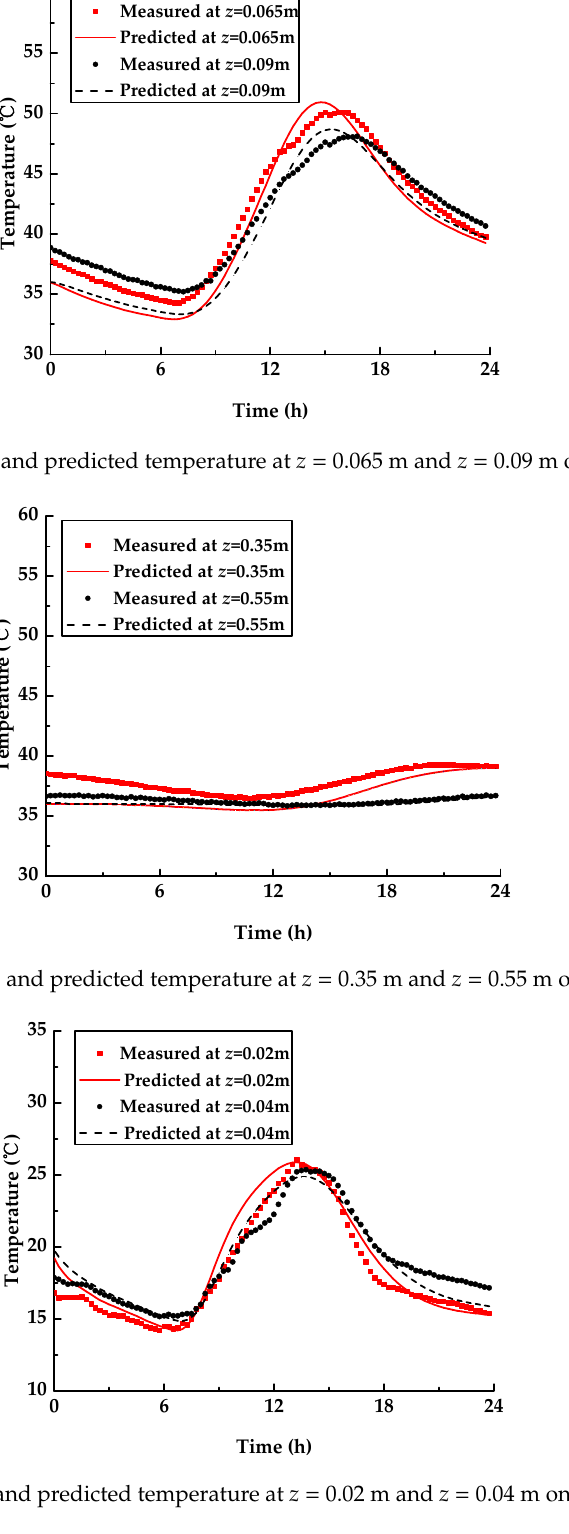
Figure 8. Measured and predicted temperature at z = 0.02 m and z = 0.04 m on 16 December.